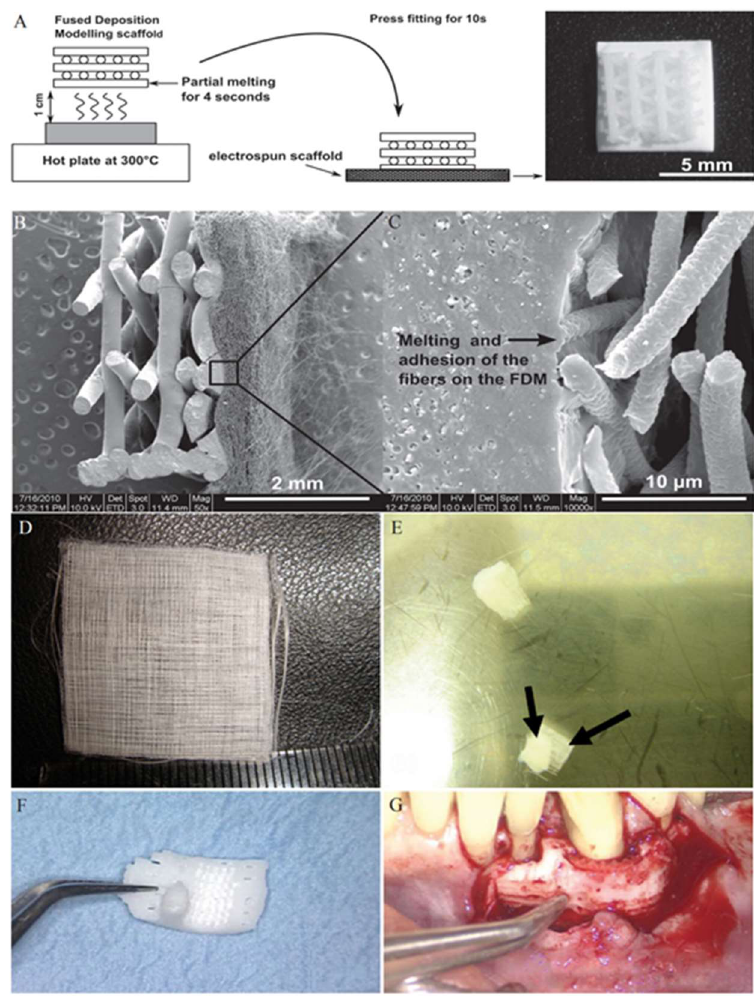
Figure 2. 3D Printed scaffolds for periodontal tissue engineering. ( A – C ) Schematic of the scaffold fabrication methodology ( A ). Cross-section showing the fusion of the electrospun fibers with the fused deposition modeling (FDM)-printed compartment of the scaffold (B,C). ( D , E ) Electron spun polycaprolactone (PCL) scaffold (D). The PCL scaffold attached to a decellularized sheet (E). ( F , G )